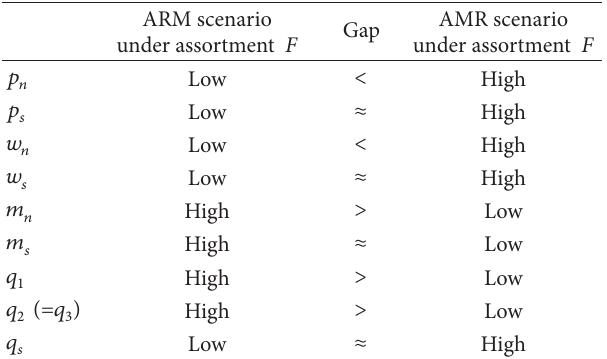
Table 1: Comparison between the ARM scenario and the AMR scenario under assortment F